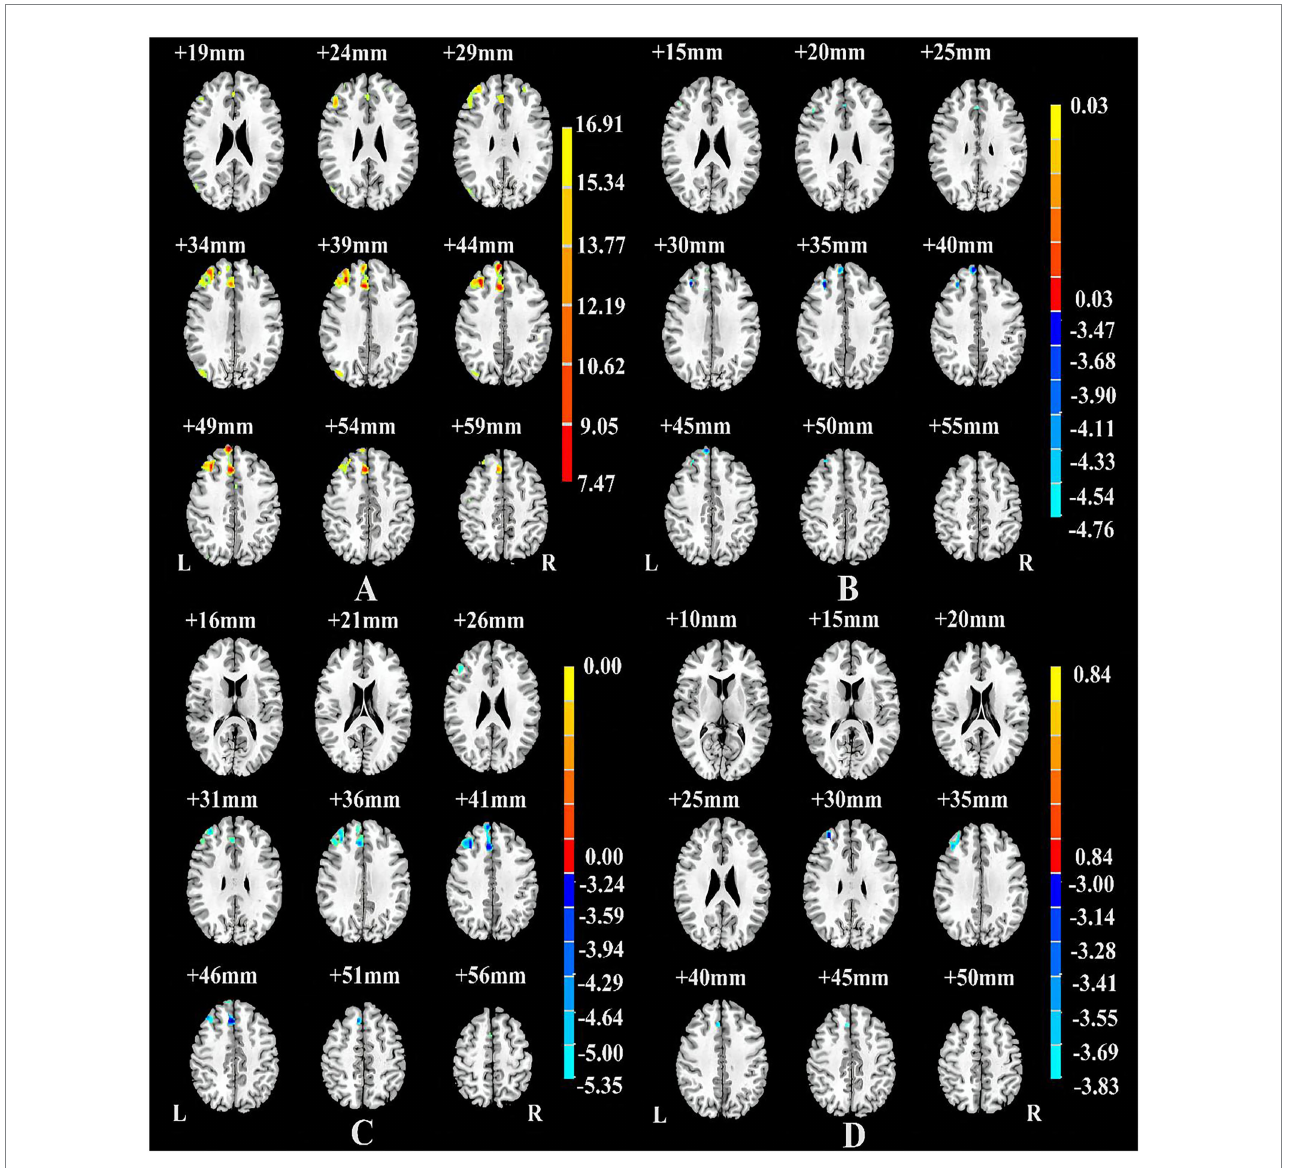
FIGURE 1 Brain regions showing differences among the Comorbid, non-Comorbid, and HC groups (A) , between the non-Comorbid group and HC groups (B) , between the Comorbid group and HC groups (C) , between the non-Comorbid group and Comorbid groups (D) . p < 0.05, corrected for multiple comparisons using FWE cluster-wise